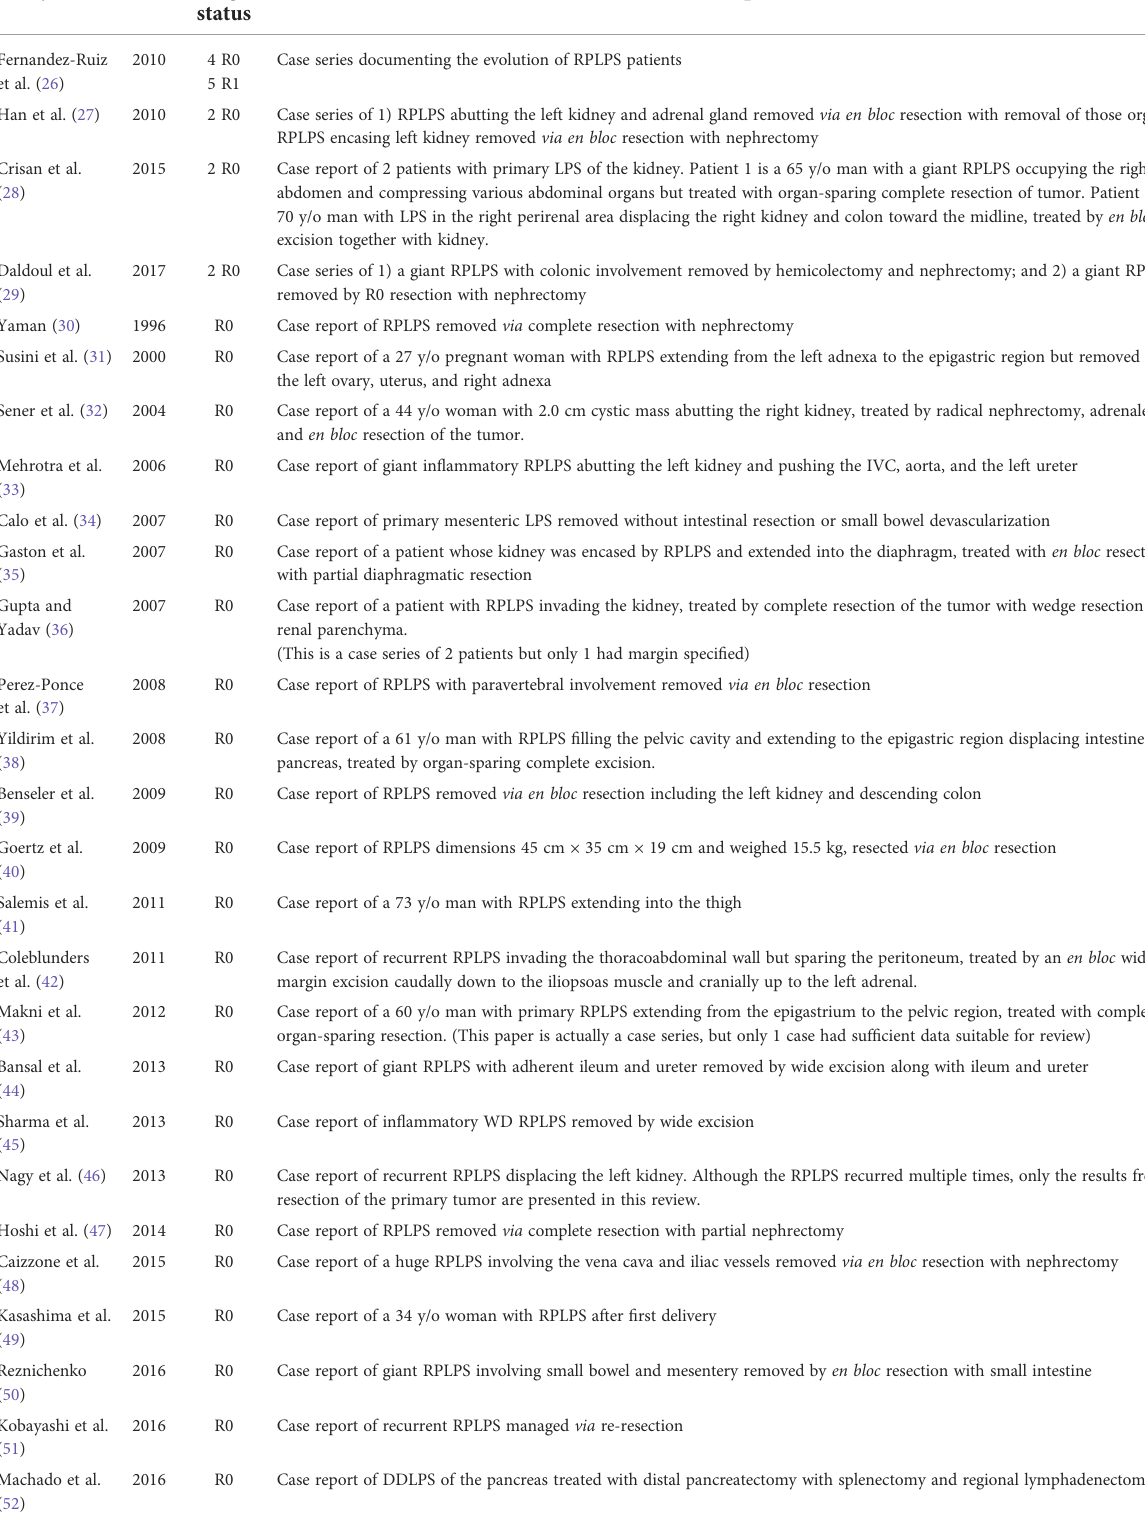
TABLE 1B List of case series/case reports reporting on retroperitoneal